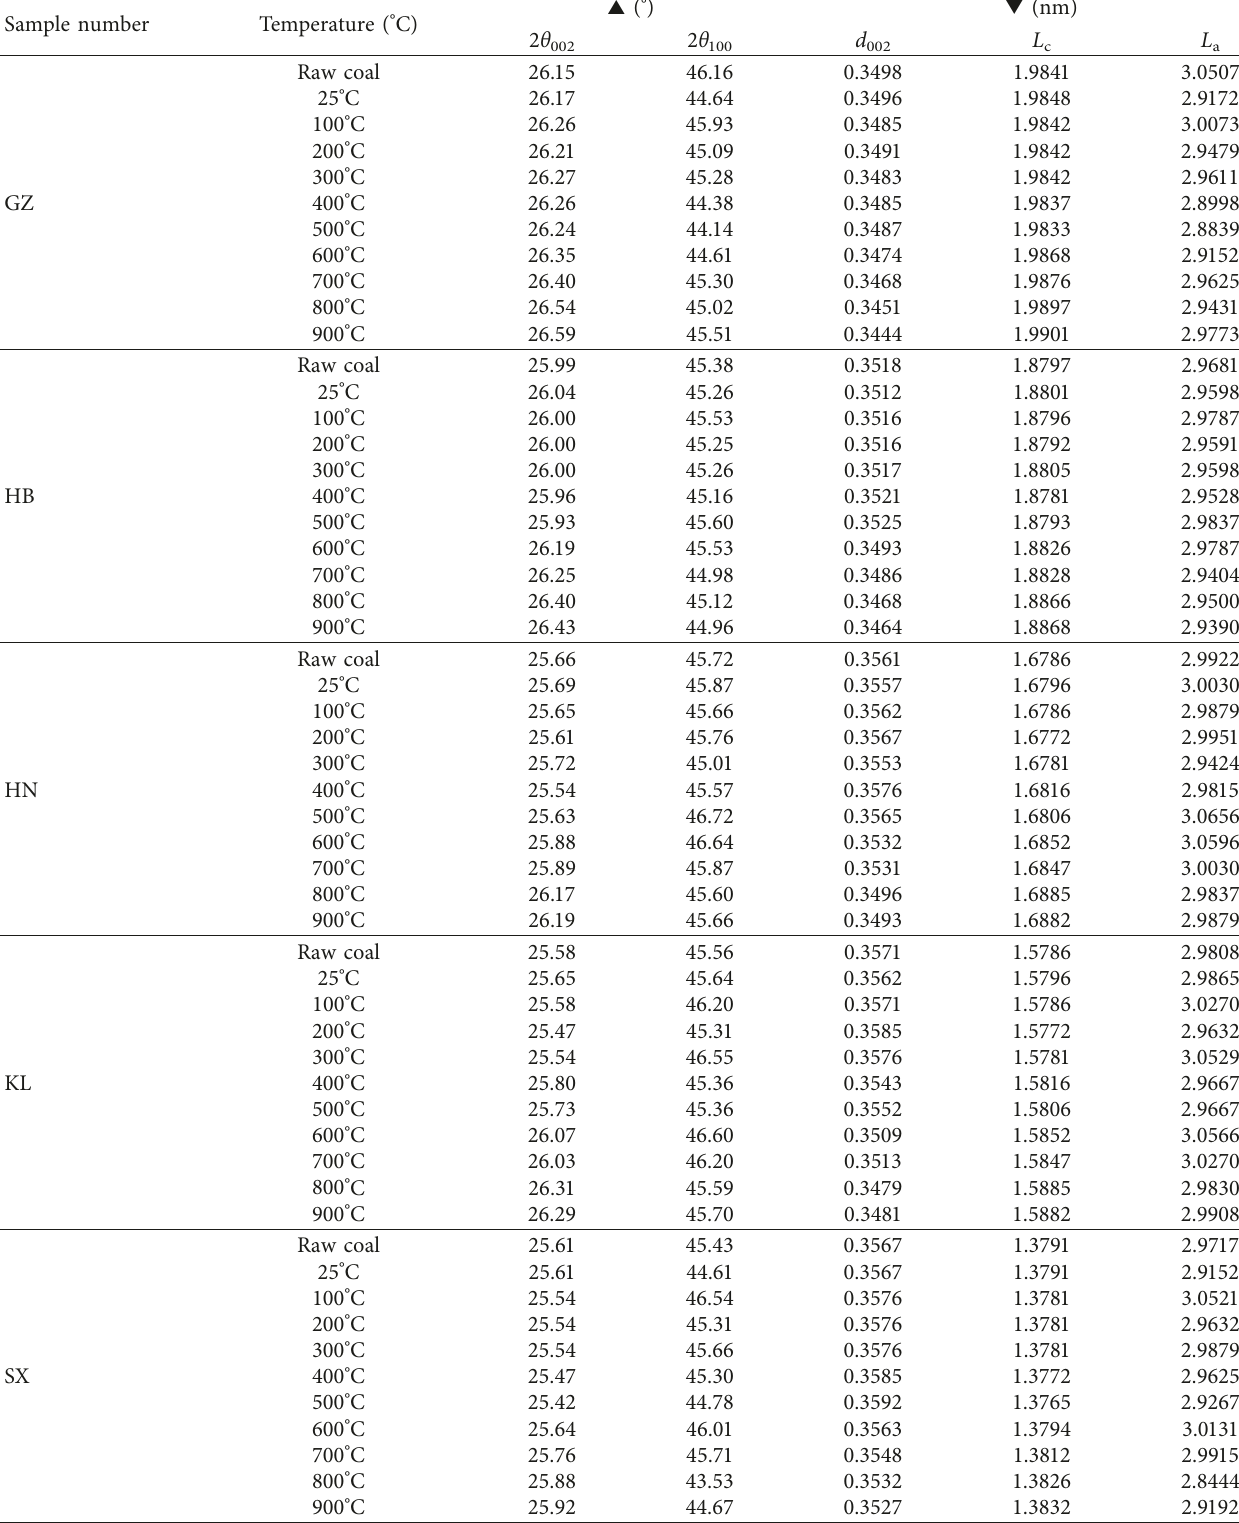
Table 3: Statistic results of the XRD parameters of five coal samples before and after pyrolysis. Sample